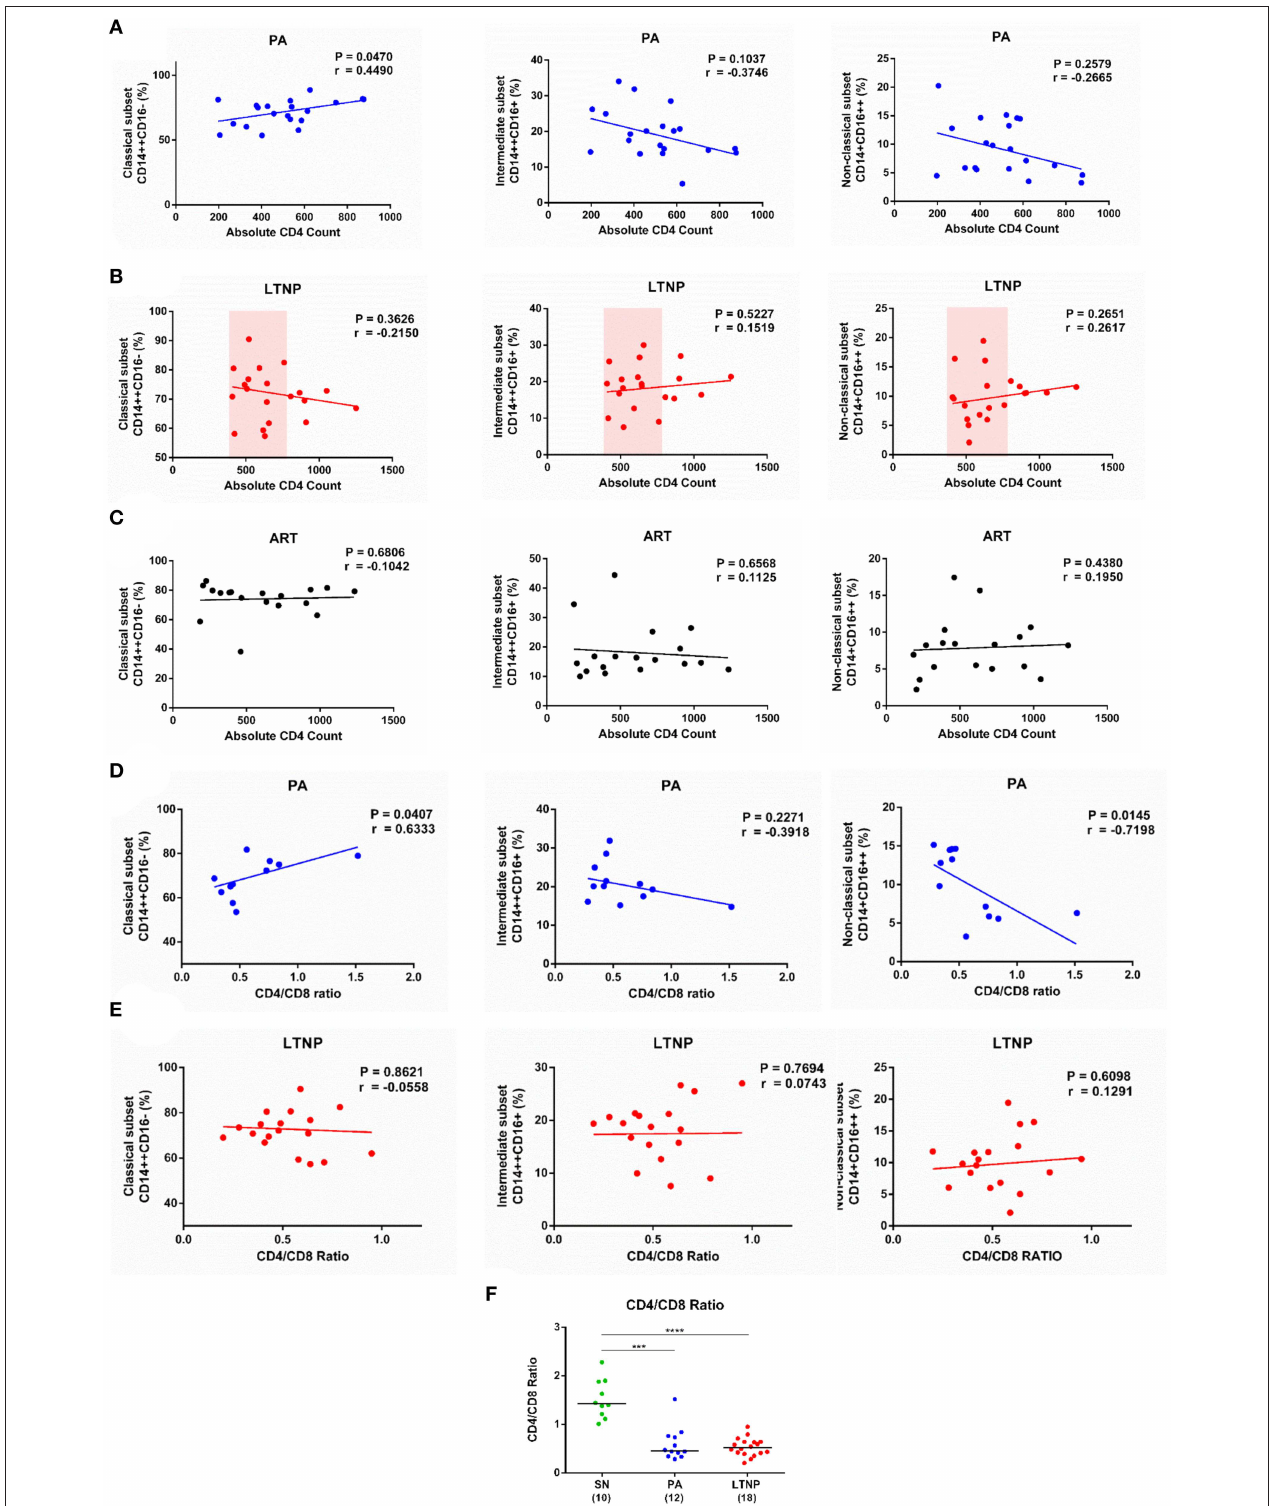
FIGURE 2 | Association of monocyte subsets with CD4 count and CD4/CD8 Ratio. (A–C) Correlation analyses of monocyte subset frequencies with absolute CD4 count in the PA ( n = 20), LTNP ( n = 20), and ART ( n = 18) groups, respectively. Note the clustering of absolute CD4 counts around the median value of 500 cells/ µ